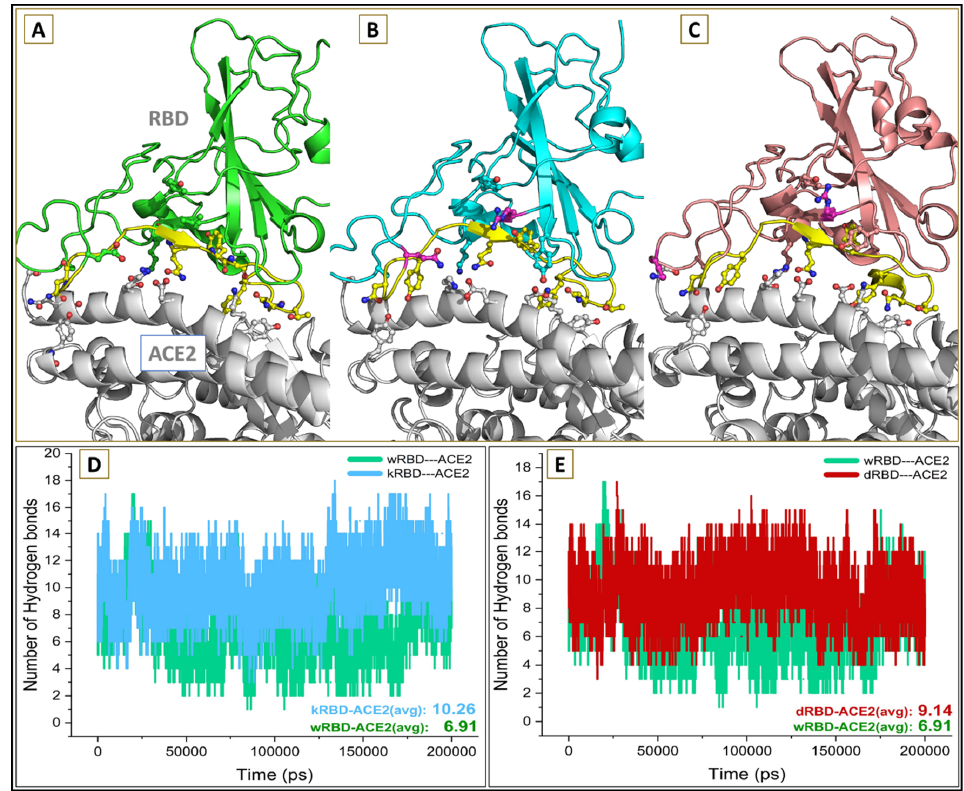
Figure 7. The interfacial binding region between ( A ) wtRBD–ACE2 in green, ( B ) kRBD–ACE2 in cyan and ( C ) dRBD– ACE2 complex in pink color. The average number of intermolecular hydrogen bonds between ( D ) wtRBD–ACE2 (green) and kRBD–ACE2 (cyan) and ( E ) wtRBD–ACE2 (green) and dRBD–ACE2 (red).